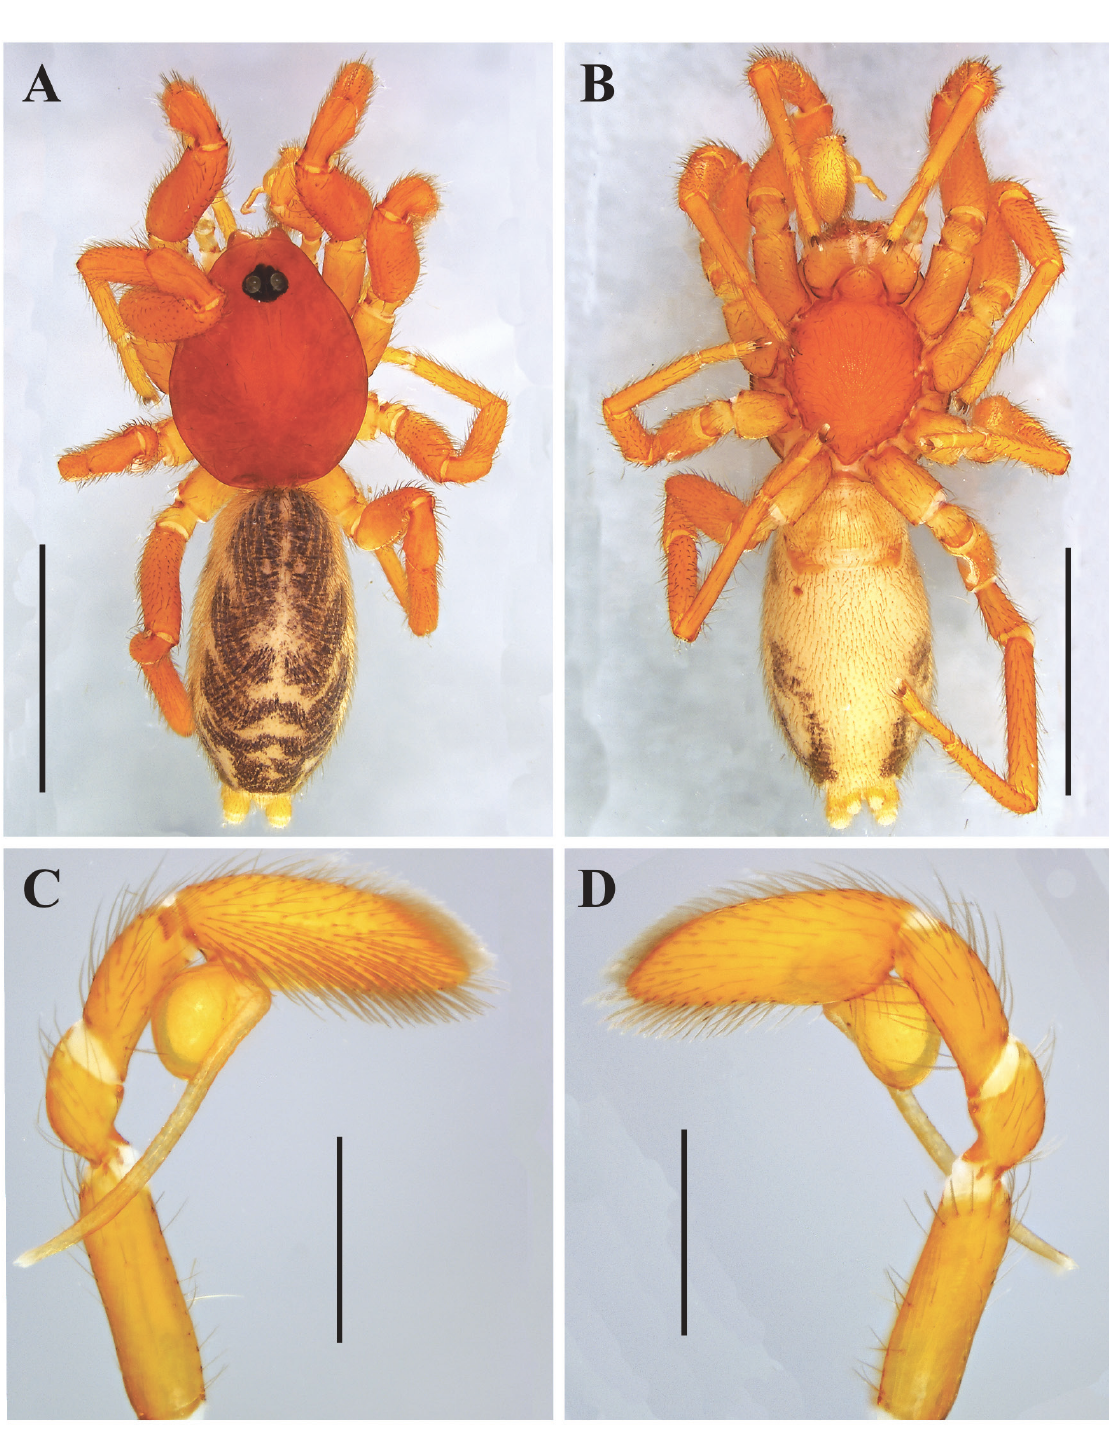
Fig. 3. Medionops cauca sp. nov., holotype, ♂ (IAvH-I 3788). A . Habitus, dorsal view. B . Habitus, ventral view. C . Left palp, retrolateral view. D . Left palp, prolateral view. Scale bars: A–B = 1.5 mm; C–D = 0.5